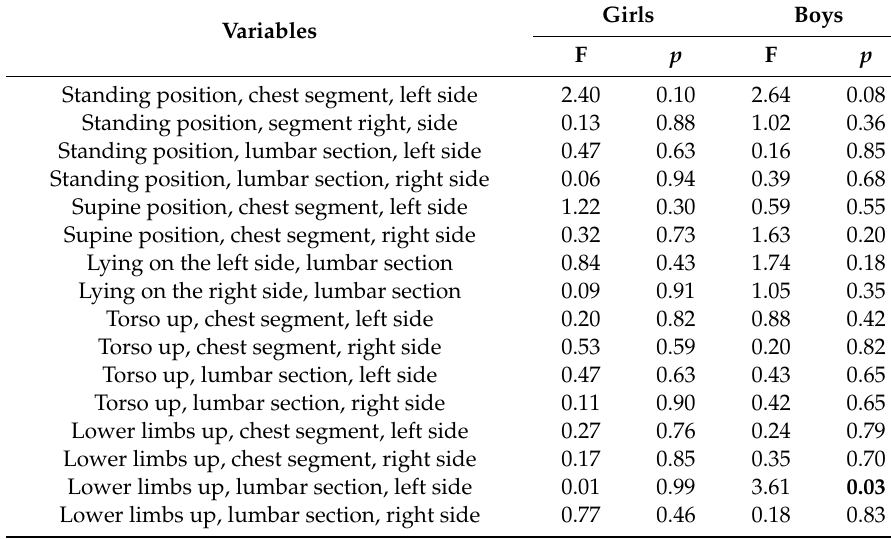
Table 4. Analysis of ANOVA di ff erences for SEMG amplitude of the erector spinae between the scoliotic, scoliotic posture, and normal posture groups of boys and